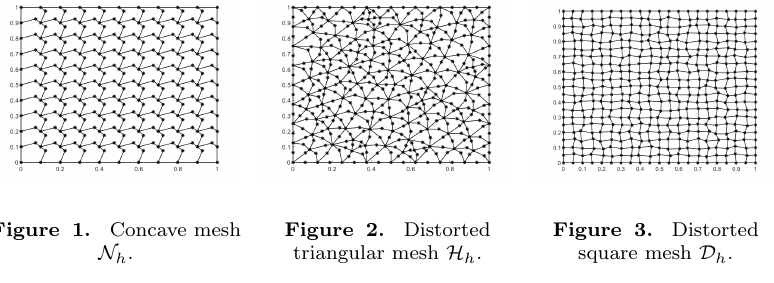
Figure 3. Distorted square mesh D h